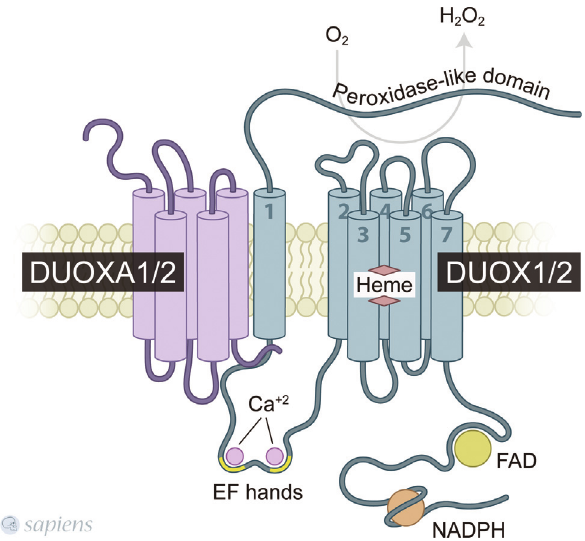
Figure 1 - Schematic structures of DUOX and DUOXA proteins. DUOX enzymes have seven transmembrane domains, with two calcium-binding sites in its large intracellular loop. They also have an N-terminal extracellular domain called the peroxidase homology domain, due to its similarity with thyroperoxidase. DUOX activator protein (DUOXA), DUOXA1 and DUOXA2, are necessary to ER-to-Golgi transition and tar- geting of DUOXs to the plasma membrane. DUOXA is co-localized with DUOX at the plasma membrane, and this association is crucial to DUOX activity. DUOX, Dual oxidase; DUOXA, DUOX activator protein. The figure was created using Adobe Illustrator